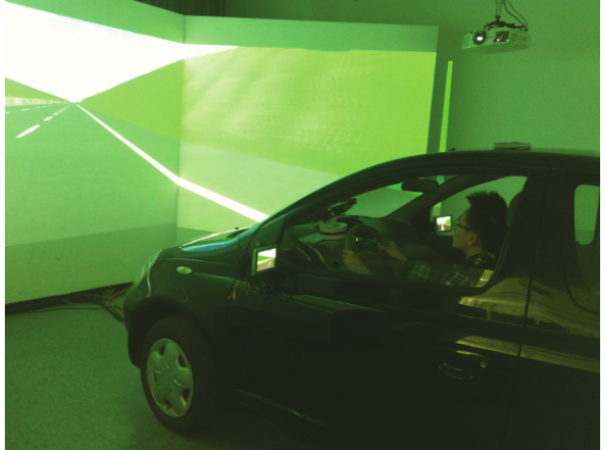
Figure 1: A tester drove in the